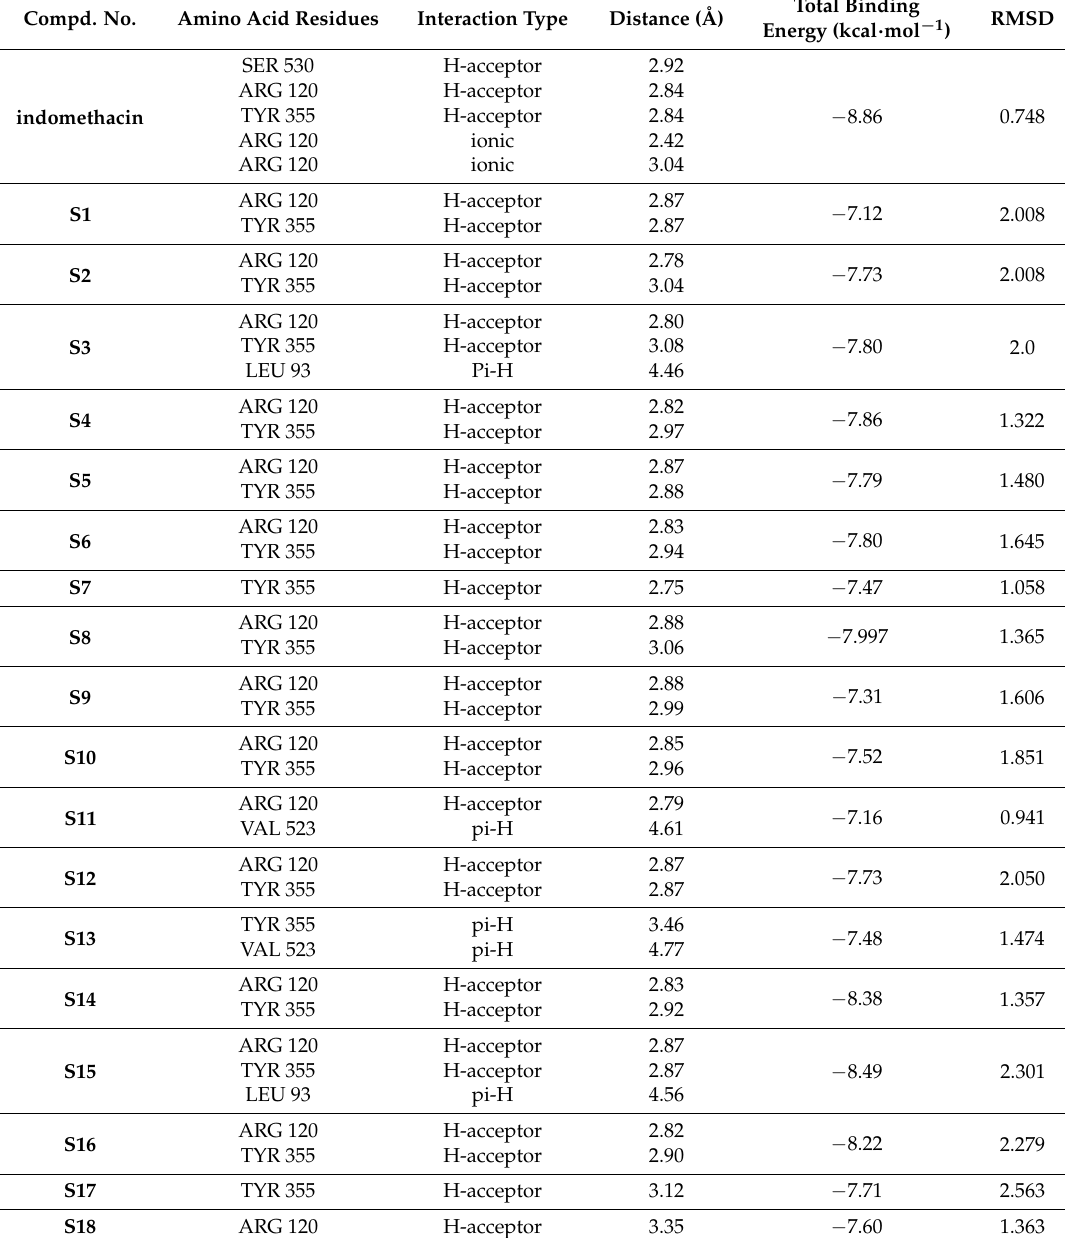
Table 5. Docking of compounds ( S1 – S18 ) into COX-2 with reference drug indomethacin. Compd.